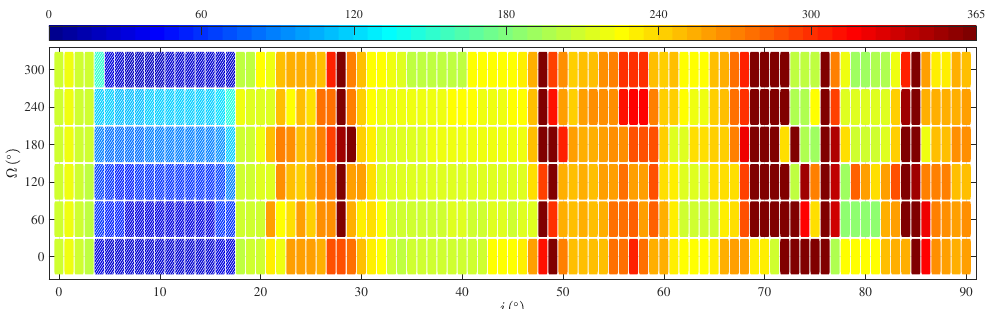
Figure 13. The lifetime counted from the beginning of orbit maintenance to the collision on the surface of the Moon is maintained by thrust (cid:107) T (cid:107) = 10